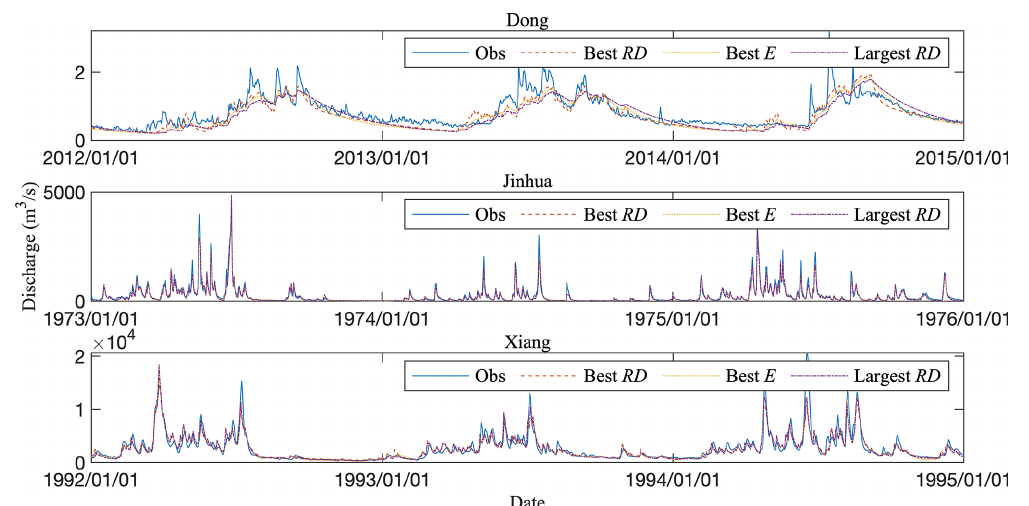
Figure 5. Typical examples of models: those with the best RD, the best E and the largest RD (representative 3 year hydrographs are